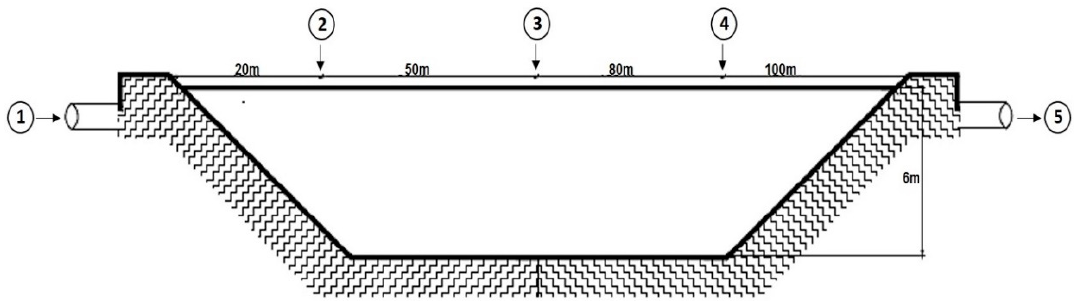
Figure 1. Scheme of the lagoon type biodigester. Cross-sectional view showing the sampling sites. Influent (1), beginning (2), middle (3), final (4) and effluent (5).